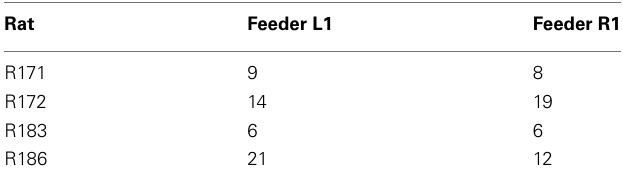
Table 2 | Identifies the number of cells, within rat, that responded explicitly to either Left feeder 1 reward (banana) or Right feeder 1 reward